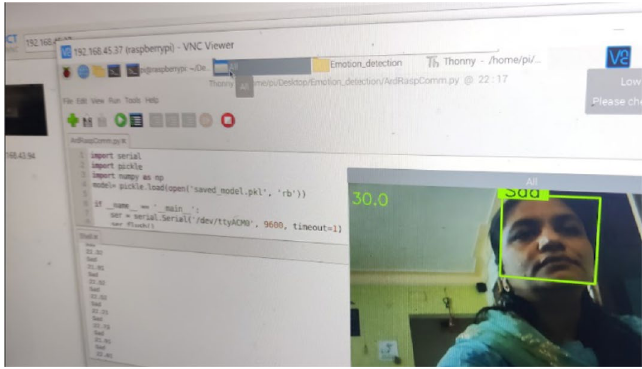
Fig. 10 The bounding box for face detection and sad emotion detection on raspberry pi camera and GSR showing skin conductance and sad emotion label and the left bottom of the